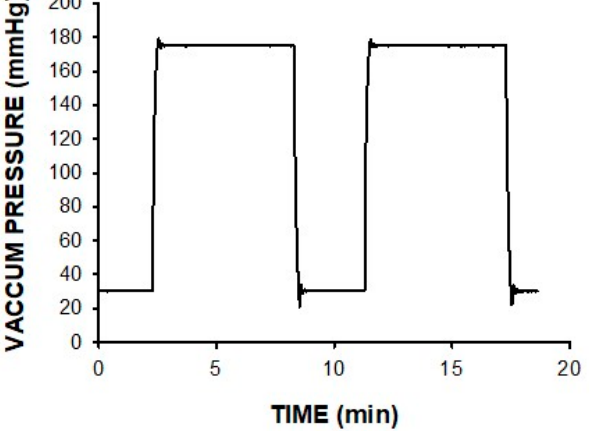
Figure 4. Vacuum pressure actually recorded at the wound phantom when the prototype of negative pressure device (Figures 1 and 3) was set to an intermittent pattern consisting of 6 min at 175 mmHg and 3 min at 30 mmHg.